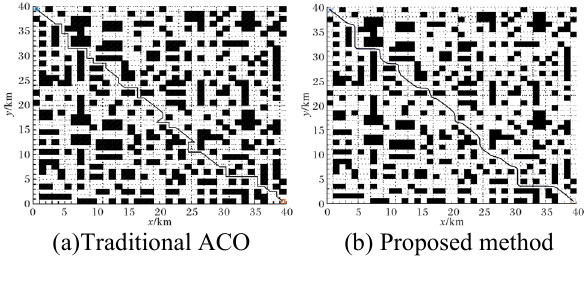
Figure 7. Comparison of traditional ant colony algorithm and the proposed algorithm under static environment 2.